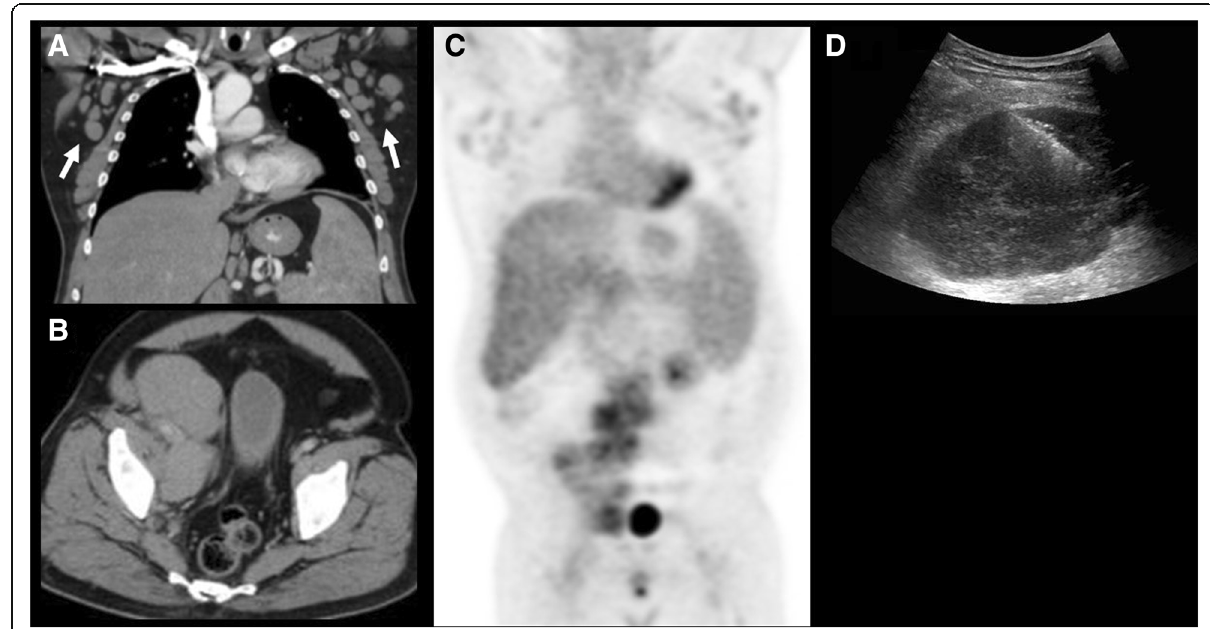
Fig. 2 A 59-year-old man with chronic lymphocytic leukemia presenting with new onset night sweats, fatigue and left upper quadrant pain. a Coronal reconstructed and axial ( b ) CT images acquired during portal venous phase at the time of symptoms shows mildly enlarged axillary lymph nodes (arrows) and right pelvic adenopathy. c PET image demonstrated FDG-avidity of the pelvic lymph node. d Ultrasound guided biopsy of the right pelvic adenopathy demonstrated histologic transformation to EBV-positive Hodgkin lymphoma polypoid or infiltrative lesions, with rare gastrointestinal ocular appendages ( adnexa oculi ) shows homogeneously obstruction (Fig. 3) [45]. Splenic MZL demonstrates vari- enhancing T2-hyperintense or hypoattenuating soft tissue able spleen involvement in the form of single or multiple infiltrating the adnexa on CT or MRI. MALT lymphoma focal lesions, splenomegaly, or miliary lesions (smaller of the lung shows nodules, reticulations, consolidations, than 0.5 cm) [46]. Sensitivity of PET/CT for MZL diagno- and peribronchial infiltrates [43, 45]. Imaging findings of sis ranges from 49 to 95%, depending on MZL subtype gastrointestinal tract MALT lymphoma include smooth